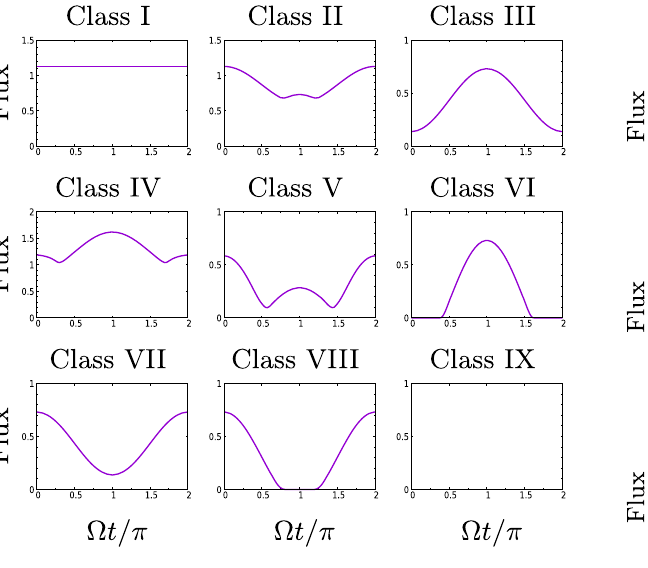
Fig. 22 Representative pulse profiles of each class